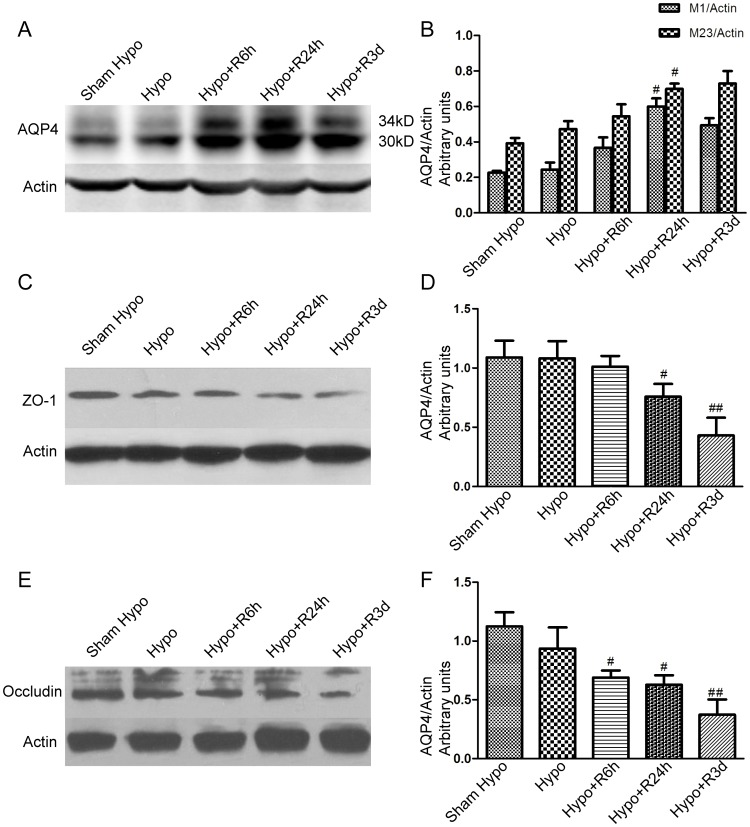
Increased expression of AQP4 protein after hypoglycemia/recovery and decreased expression of tight junction proteins.A. In the representative picture, there are two bands detected for AQP4, corresponding to M1 (34 kD) and M23 (30 kD). B. Quantification of AQP4 expression. Two isoforms both increased with a higher proportion of M1∶M23 in the 24-h recovery group after hypoglycemia versus sham hypoglycemia group. C. Representative picture revealed the decrease of ZO-1 after hypoglycemia. D. Quantification of ZO-1 expression. E. Representative immunoblot of occludin. A significant change of occludin was found after 6 h of hypoglycemia/recovery. F. Quantification of occludin protein expression. # p<0.05,## p<0.01, compared with sham hypoglycemia. (Dunnett's method, n = 5).